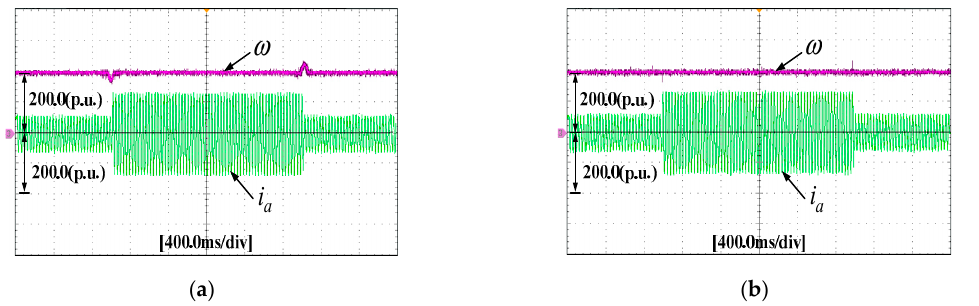
Figure 12. Experimental comparison of the two controllers against step change of the load torque. ( a ) Conventional PI and ( b ) proposed CRFTPC.